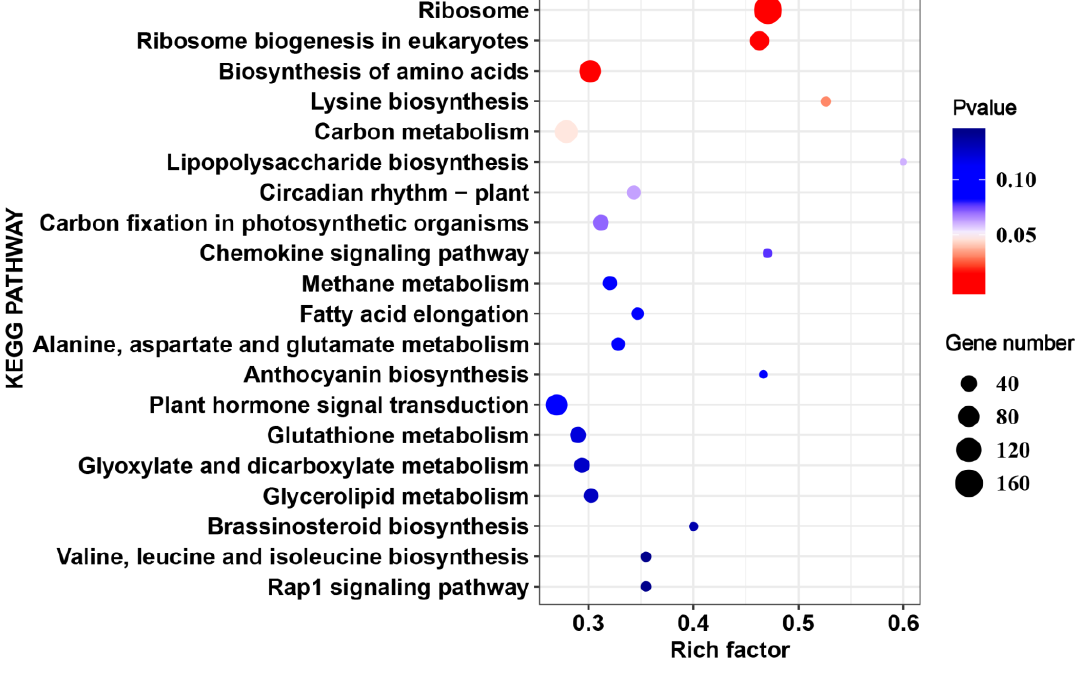
Figure 5. Top 20 enriched pathways for 17CL30-specific heat responsive genes.